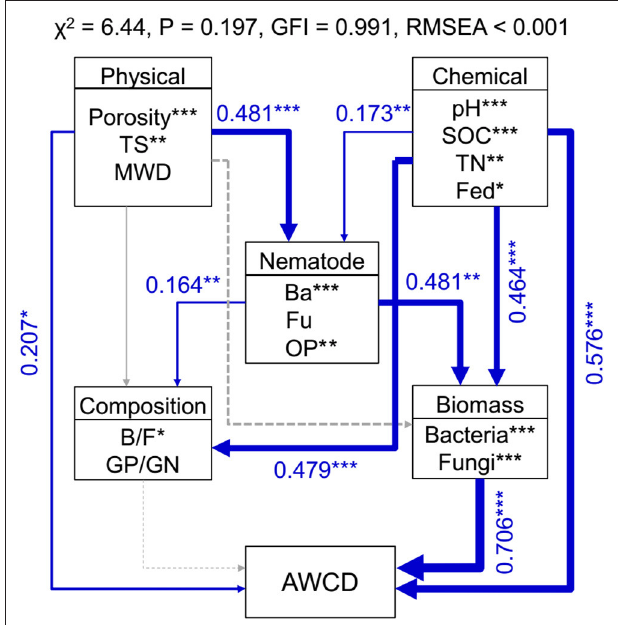
FIGURE 6 | Structural equation modeling shows the direct and indirect effects of soil properties and nematodes on bacterial biomass, community structure, and carbon metabolic activities in soil macroaggregates. Microbial carbon metabolism was reflected by the average well color development (AWCD). Blue lines indicate positive effects. The width of arrows indicates the strength of significant standardized path coefficients. Paths with non-significant coefficients are presented as gray lines. The fitness of structural equation modeling is assessed on the basis of non-significant χ -square test ( P > 0.05), goodness-of-fit index (GFI), and the root mean square error of approximation (RMSEA). SOC, soil organic carbon; TN, total nitrogen; Fed, dithionite-citrate-bicarbonate soluble Fe; TS, Tensile strength; MWD, mean weight diameter; Ba, bacterivores; Fu, fungivores; OP, omnivores and predators; B/F, the ratio of bacteria to fungi; GP/GN, the ratio of Gram-positive bacteria to Gram-negative bacteria. *** P < 0.001, ** P < 0.01, * P <